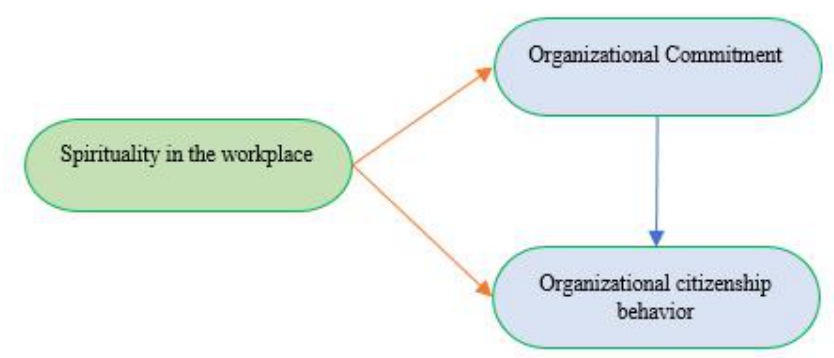
Fig. 2: Conceptual model and framework of